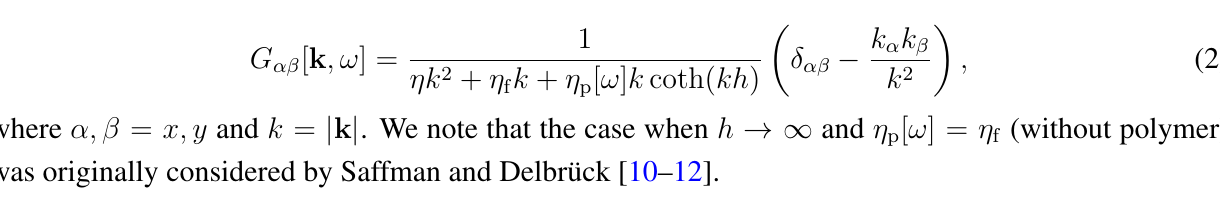
Figure 1. Schematic picture showing a planar viscous membrane with 2D viscosity (cid:17) . It is supported by a viscoelastic polymer cushion of 3D frequency-dependent viscosity (cid:17)